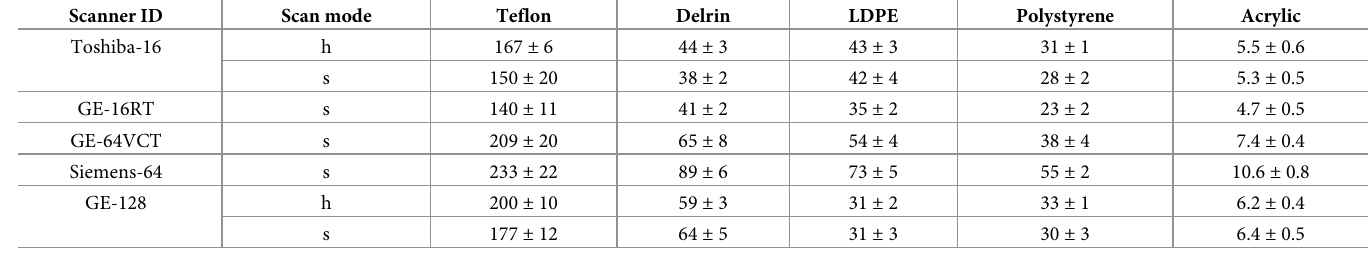
Table 6. CNR values (mean ± standard deviation across five repeated measurements) of different inserts from the CTP404 phantom, for each CT scanner/acquisi- tion protocol. Scanner ID